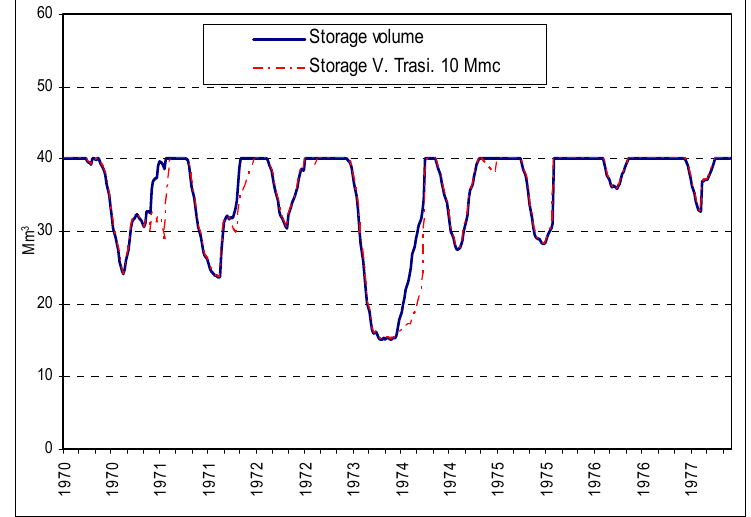
Figure 8. Detail of the stored volumes during the most critical period (1970–1977), with and without